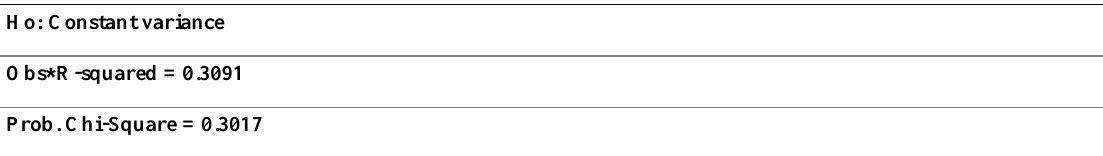
Table 4: Heteroskedasticity